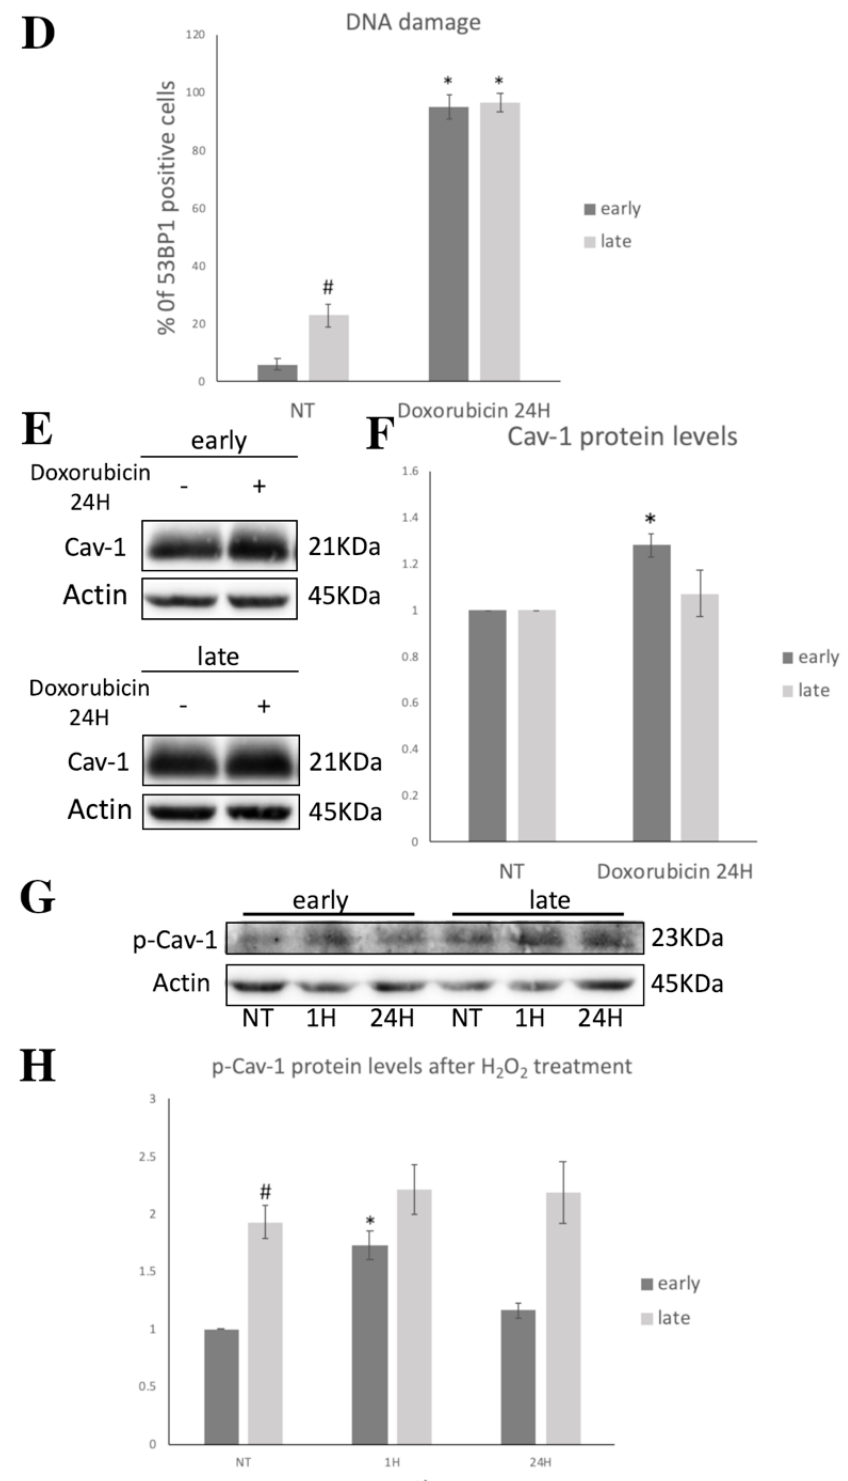
Figure 3. No alterations in Cav-1/pCav-1 levels in late-passage cells after exogenous oxidative insult. ( A ) Representative immunoblot of cell lysates of early- and late-passage WJ-MSCS (from three donors) that have been exposed to H 2 O 2 (300 µ M, 30 min) and left to recover for 24 h, analyzed at four different time points (NT(=No Treatment), 1 h, 3 h, and 24 h of recovery time post-treatment) by western blotting using the anti-caveolin-1 (Cav-1) antibody. ( B ) Quantification of relative protein expression levels of Cav-1 in cell lysates from early and late WJ-MSCs (from 3 donors) after being exposed to H 2 O 2 was performed based on band density using ImageJ. NT values from both early- and late-passage cells were arbitrarily set to 1. Values shown are the means ± S.E. * p < 0.05 vs. the NT condition. ( C ) Characteristic images of early- and late-passage cells where Cav-1 localization was evaluated by staining with anti-cav-1 antibody and the appropriate secondary antibody (red) under normal conditions (No Treatment — NT) and 24 h after being treated with Doxorubicin. DNA damage was also assessed by staining with the 53BP1 antibody and the appropriate secondary an- tibody (green). Nuclei were stained with DAPI (blue). Images were captured with the 40× objective lens of the fluorescent microscope used. ( D ) Percentages of WJ-MSCs with 53BP1 foci from early- and late-passage cells from three donors evaluated by staining with the 53BP1 antibody under nor- mal conditions (No Treatment — NT) and 24 h after Doxorubicin treatment. Values shown are the